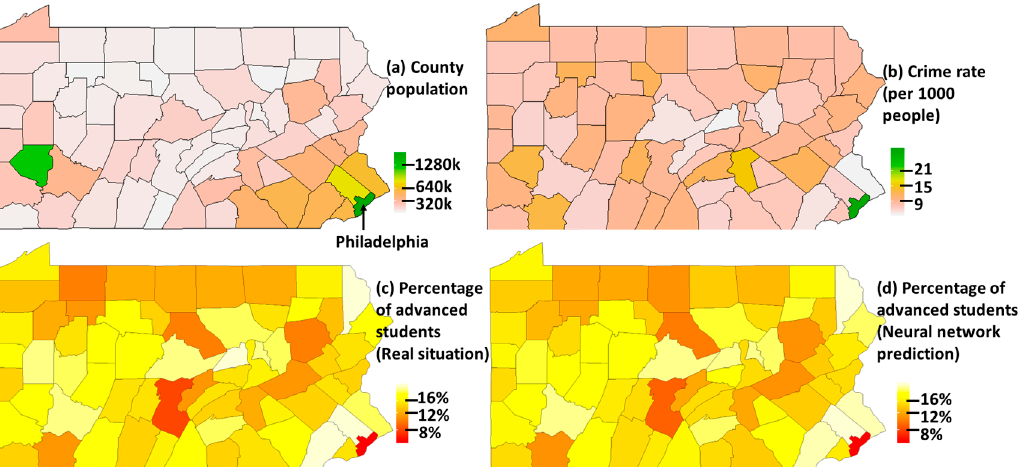
Figure 7. Heatmap of Pennsylvania showing ( a ) county population, ( b ) crime rate, ( c ) real percentage of advanced students, and ( d ) neural network predicted percentage of advanced students. Black arrow shows the special area of Philadelphia county.